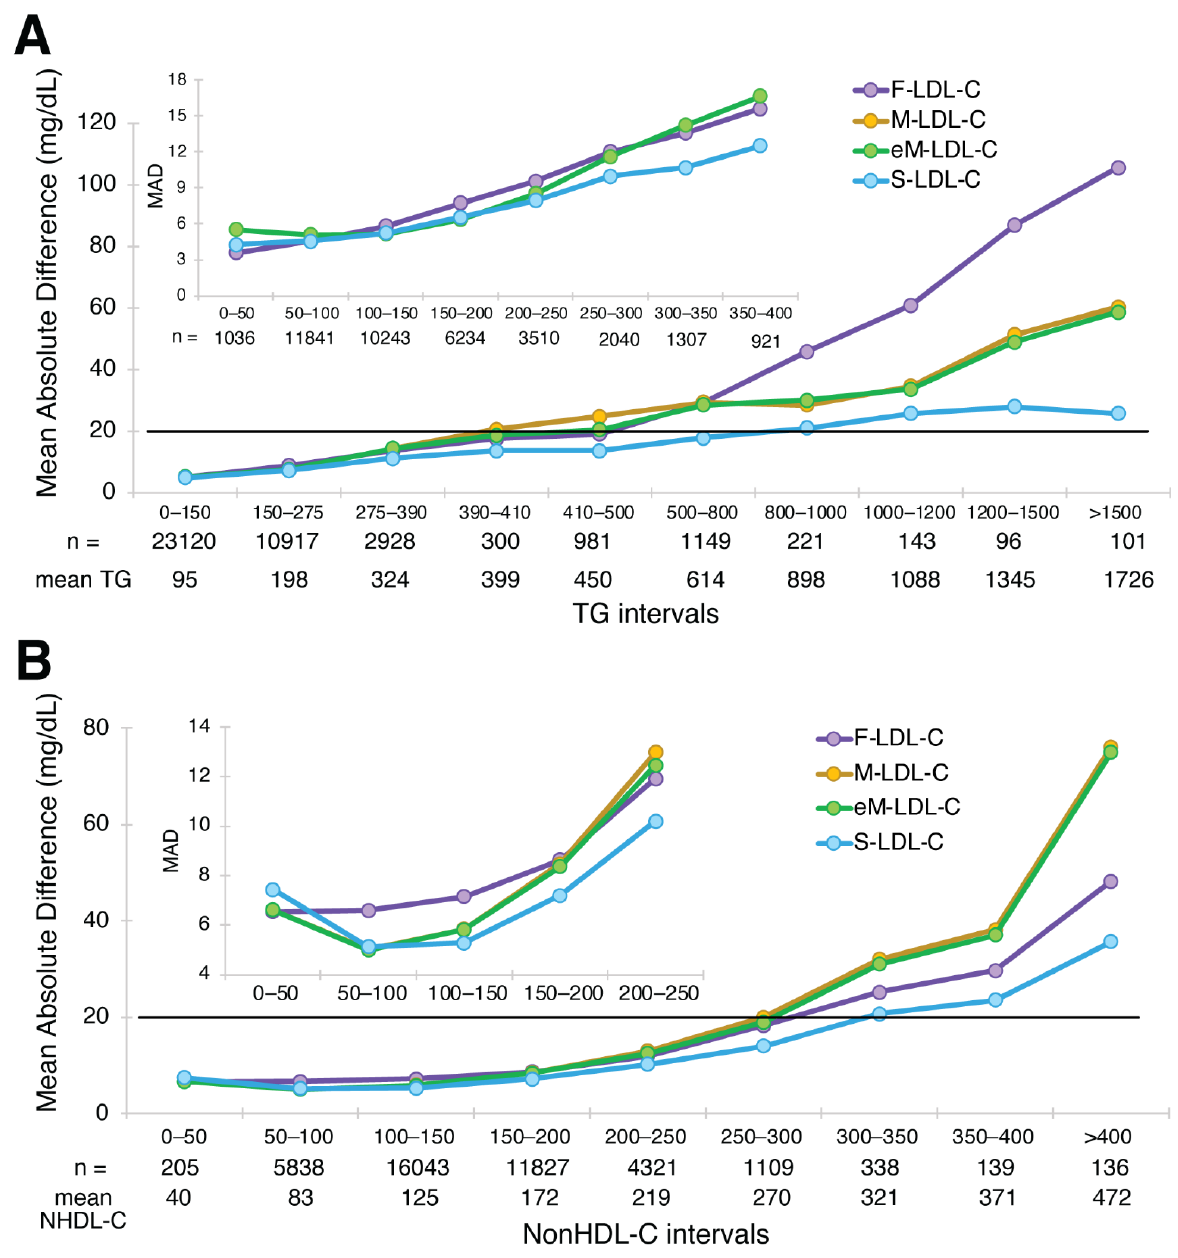
Figure 2. Mean Absolute Difference of estimated LDL-C versus BQ-LDL-C. Mean absolute difference (MAD) score for LDL-C from patients (N = 39,956) with a wide range of LDL-C values is shown for the F-LDL-C (purple line), the M-LDL-C (orange line), eM-LDL-C (green line) and S-LDL-C (light blue line) equations for the indicated TG intervals (Panel A ) and nonHDL-C intervals (Panel B ). The inset shows a close-up for low TG and low nonHDL-C samples. The number of samples within the interval is indicated, as well as the mean value for the interval. Solid black line is the level of the MAD for Friedewald at 400 mg/dL TG (20 mg/dL), which was used as a limit for acceptable accuracy for the other equations.